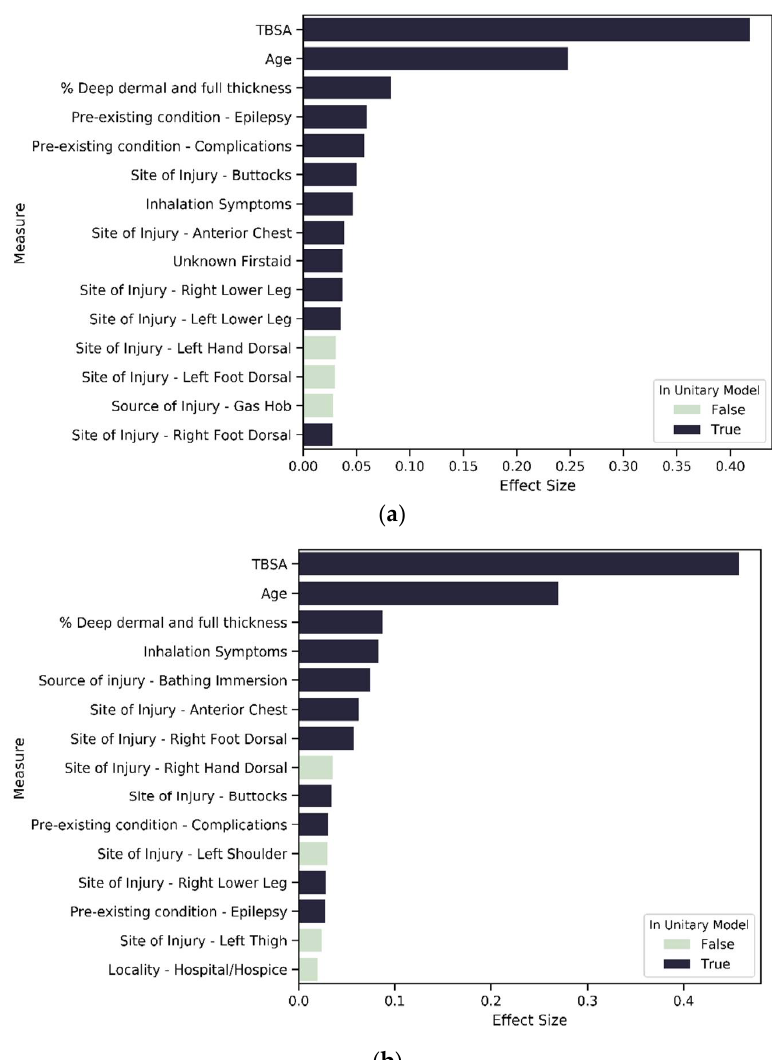
Figure 8. Variables of importance: ( a ) top 15 contributors from 196 significant variables in SES1; ( b ) top 15 contributors from 188 significant variables in SES2; ( c ) top 15 contributors from 137 sig- nificant variables in SES3.